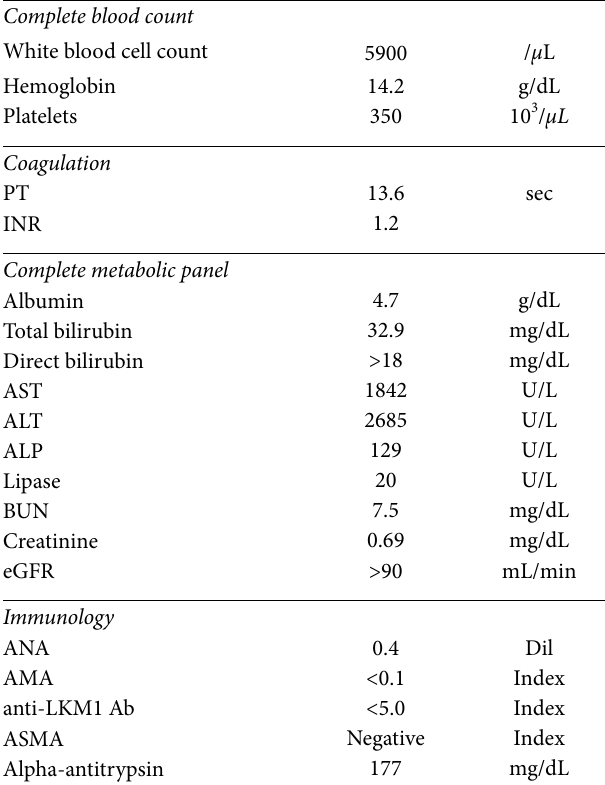
Table 1: Laboratory data on admission.